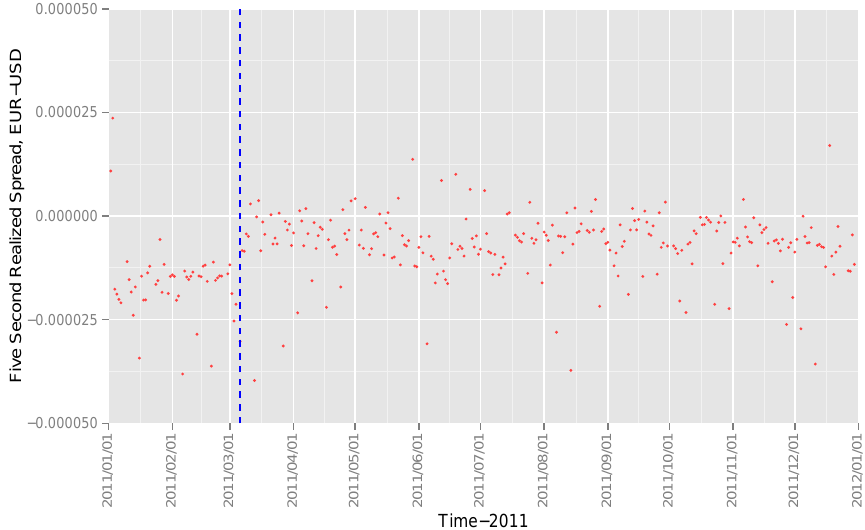
Figure 11. EUR/USD Realized Spread, Five-Second Frequency.